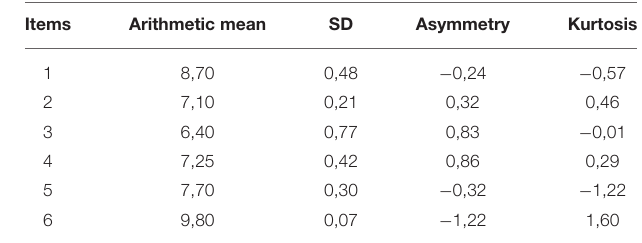
TABLE 6 | Descriptive statistical analysis of the Academic Activity Scale in Study 2 with presence learning.